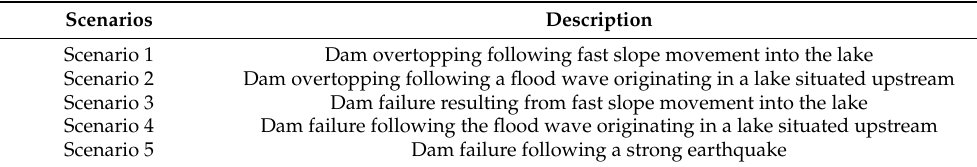
Table 4. Five different scenarios according to Emmer and Vil í mek [54]